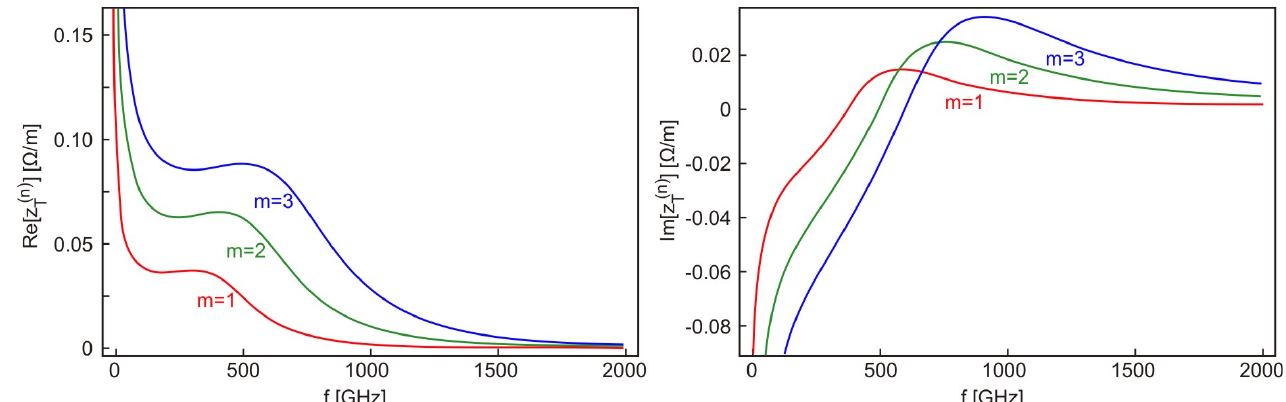
FIG. 3. (Color) Real (left) and imaginary (right) parts of transverse impedances for PETRA III vacuum chamber. Standard straight